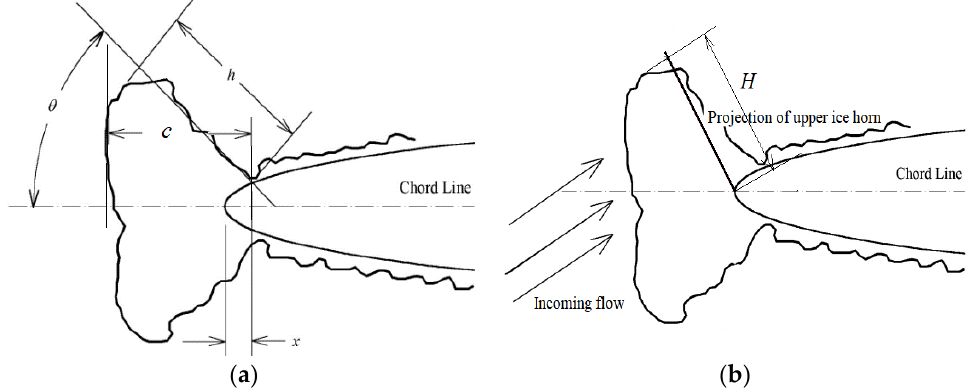
Figure 4. Characteristic parameters of the ice horn. ( a ) Ice horn dimensions. ( b ) Projection of upper ice horn in the direction of the incoming flow.